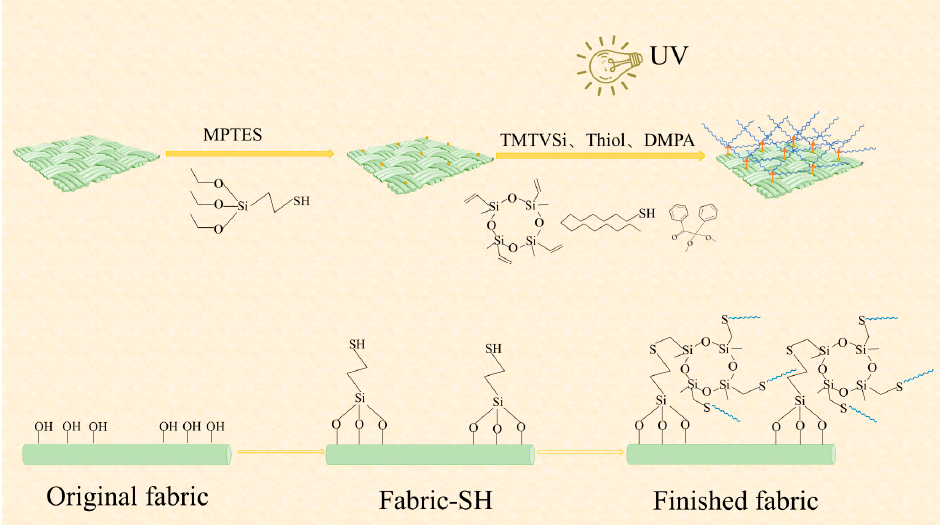
Figure 1. Schematic diagram of the reaction mechanism of cotton fabric modification.